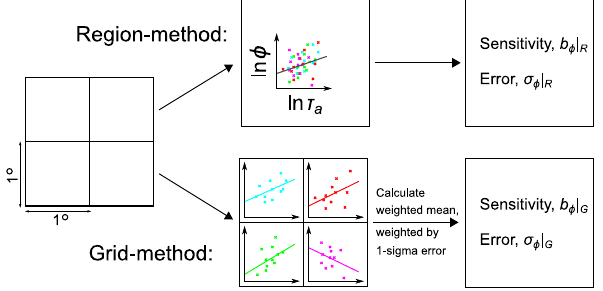
Fig. 1. A schematic illustrating the methods used to calculate sensi- tivities, applied to a 2 ◦ × 2 ◦ region. Each point in the scatter plot rep- resents a 1 ◦ × 1 ◦ grid box and day for which both cloud and aerosol data exist. The different colours are used to show data from differ- ent grid boxes. For simplicity, only a small number of data points are shown in this